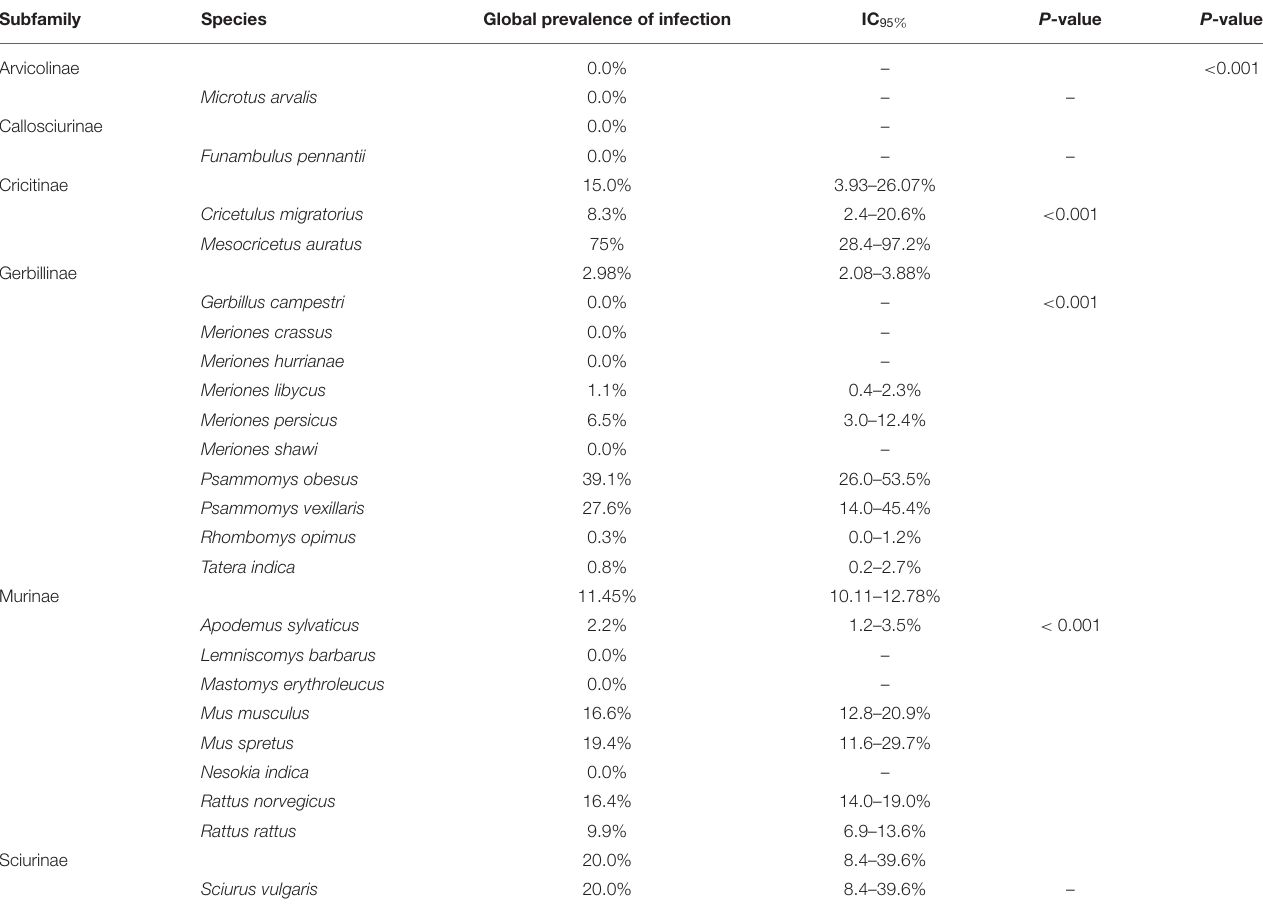
TABLE 3 | Global prevalence and IC 95 % of infection in each species and subfamily.